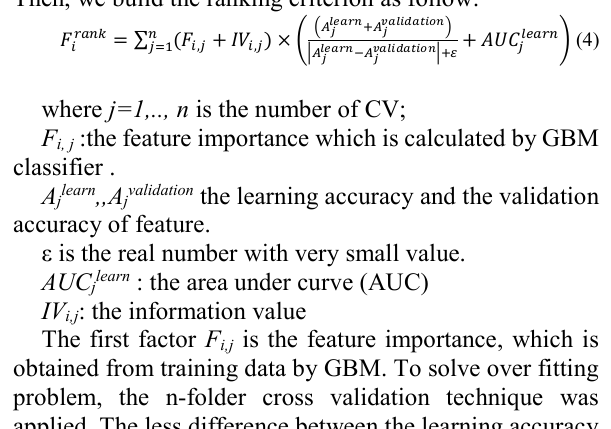
Figure 2. Gradient Boosting Algorithm